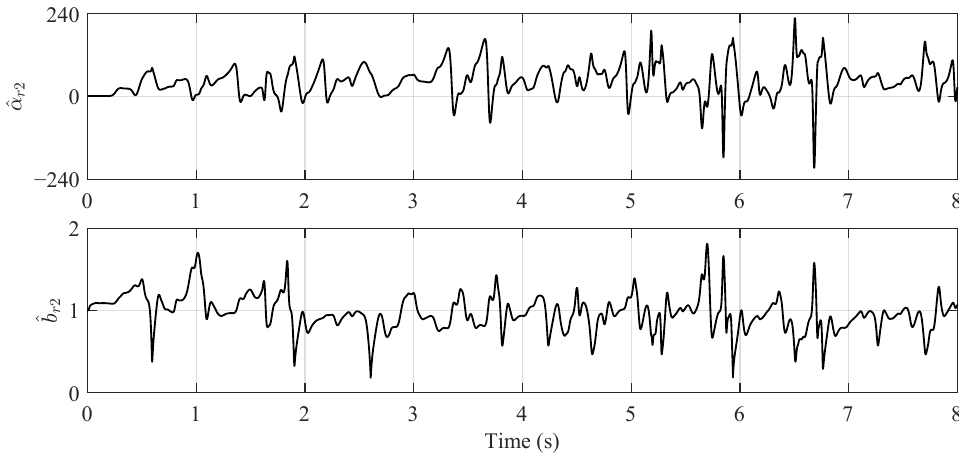
Figure 4. Estimations of the reformed plant 2’s parameters.